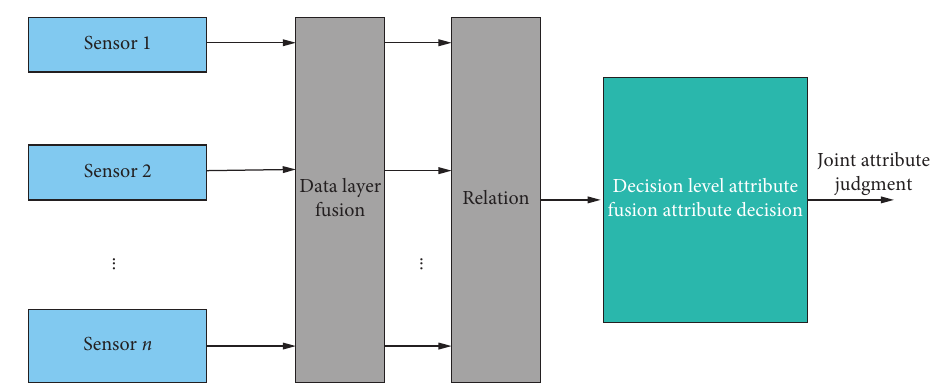
Figure 1: Data layer fusion